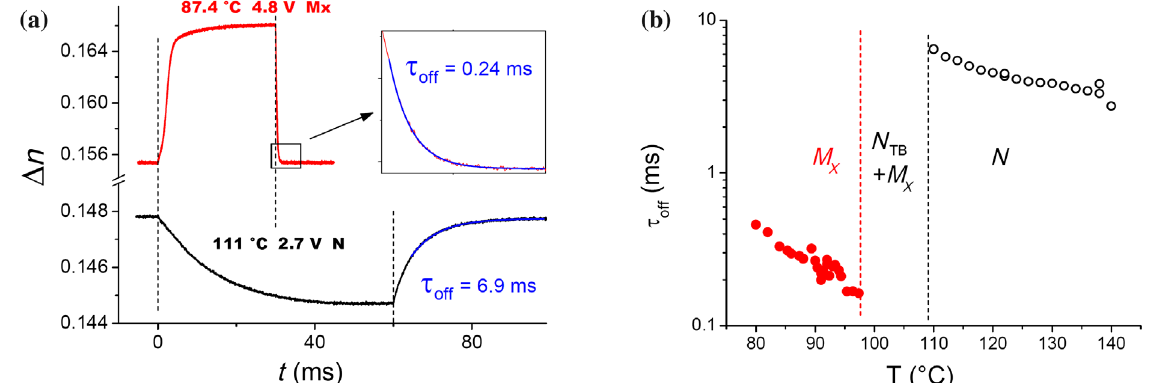
FIG. 7. Time evolution of the optical response during the Fr´eedericksz transition in the N (FrTr, black lines and symbols) and M (BFrTr, red lines and symbols) phases of the BP12 mixture (cell thickness d ¼ 1 . 4 μ m). (a) Optical response to dc pulses ( U > U dashed straight lines mark the start and the end of the pulse). The relaxation time τ faster in the M phase. Fits of the data with an exponential relaxation law are shown in blue. (b) Temperature dependence of τ X (open black symbols) and M (full red symbols) X